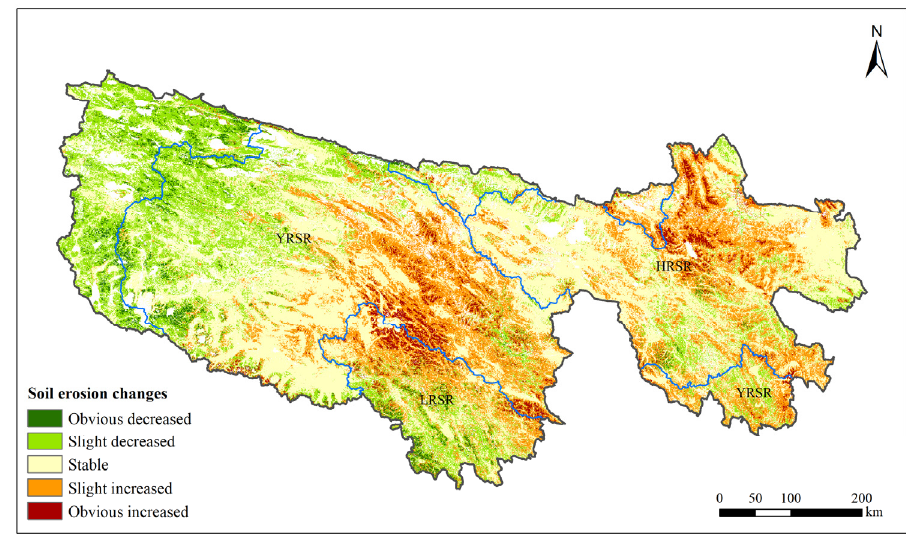
Figure 4. The soil water erosion modulus changes from 2000 to 2020 in the TRHR, China. Table 2. Area percentage of soil erosion classification of the three source regions in the TRHR,